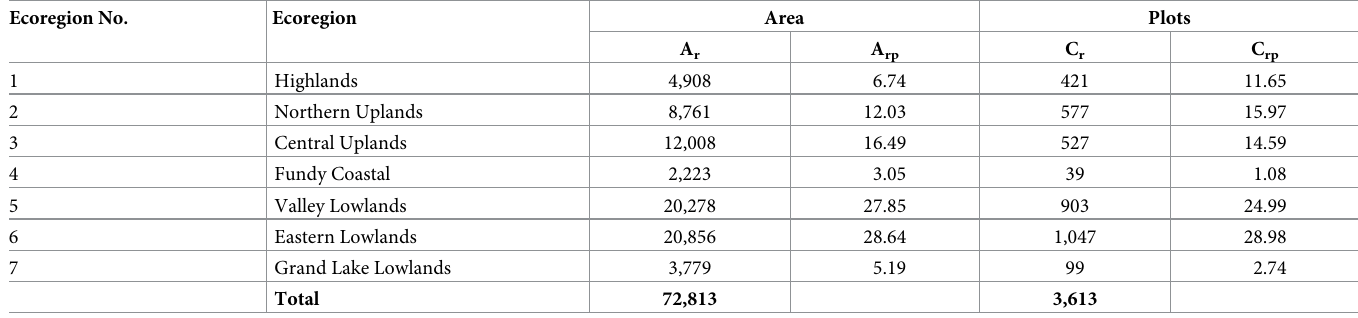
Table 1. Ecoregion and permanent sample plot (PSP) inventory summary, where A r is the ecoregion land area (km 2 ), A rp the proportion of NB that makes up the ecoregion (%), C r the number of PSPs within the ecoregion, and C rp the proportion of plots which constitute NB’s total PSP inventory within a specific ecoregion (%). Ecoregion